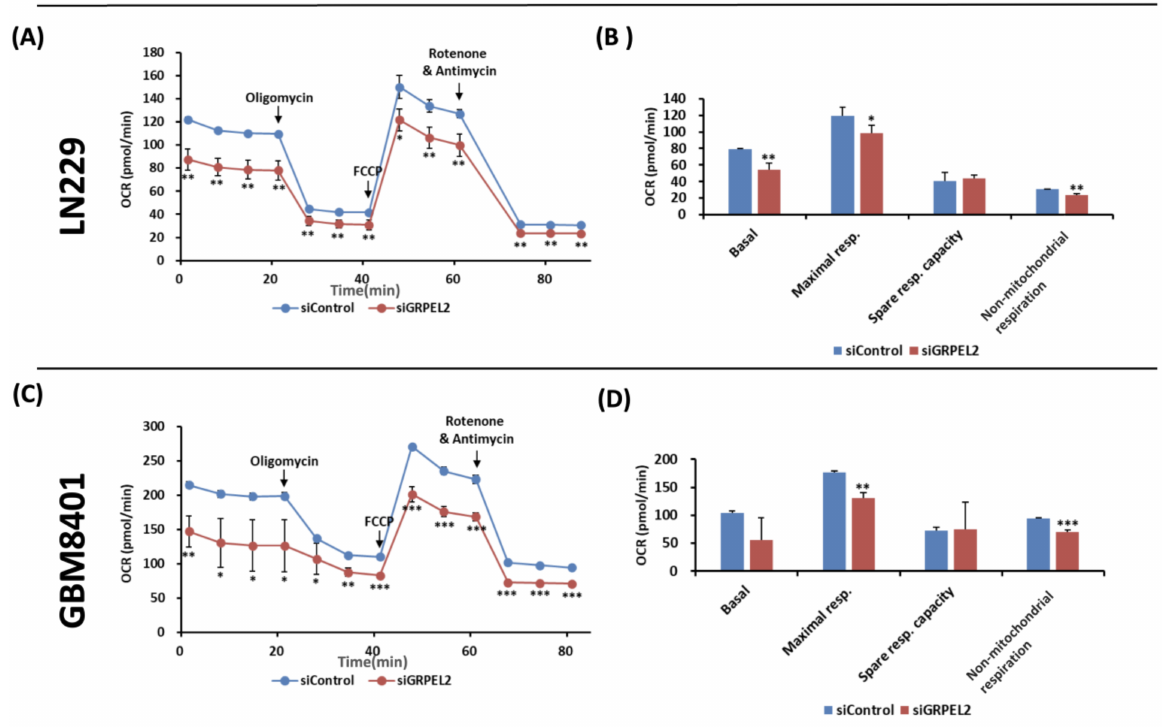
Figure 6. A Seahorse XF bioenergetic assay showed that GRPEL2 knockdown decreased OCR in LN229 and GBM8401 cells. ( A , C ) Oxygen consumption rate (OCR) of LN229 ( A ) and GBM8401 ( C ) cells treated with siControl and siGREPL2 in the Seahorse XFp analyzer. ( B , D ) Effect of GRPEL2 silencing on basal, maximal respiration, spare respiratory capacity, non-mitochondrial respiration coupling with cellular respiration of LN229 ( B ) and GBM8401 ( D ) cells. The graph A and C of OCR versus time (min) as shown is representative of four independent experiments in which three replicates of each assay were evaluated. * p < 0.05; ** p < 0.01; *** p <